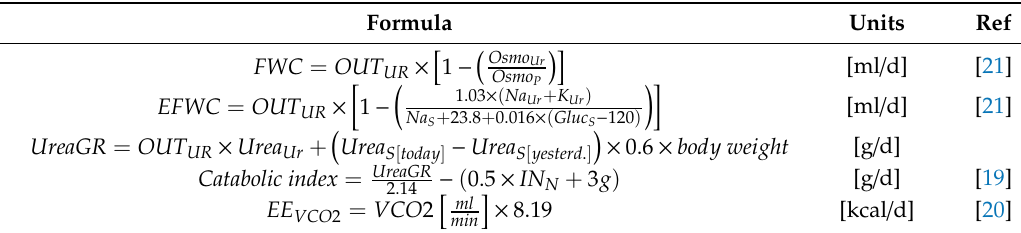
Table 1. Formulas, corresponding units and